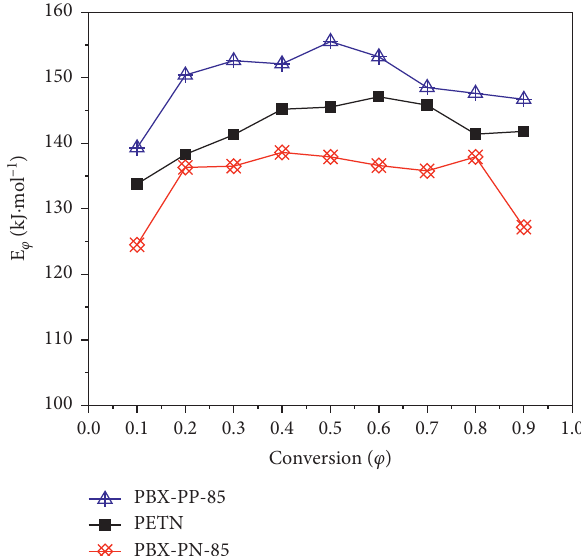
Figure 4: The dependence of activation energy on the conversion by the modified KAS